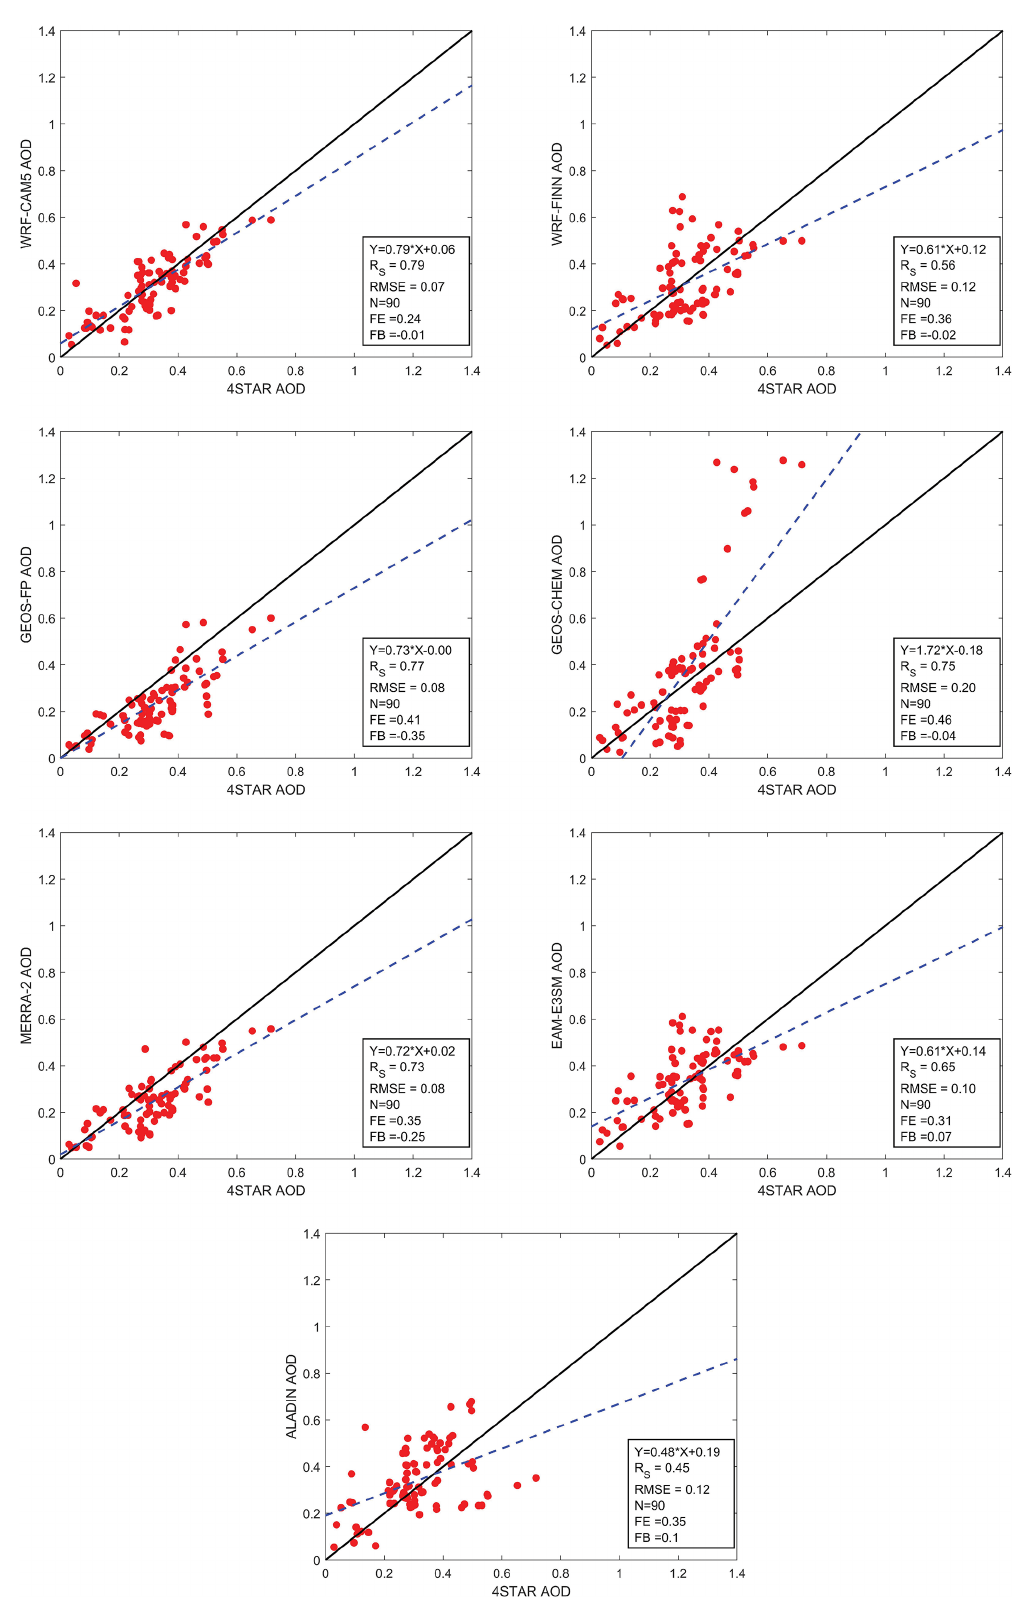
Figure 11. Scatterplots comparing modeled AOD (at 550nm) and 4STAR AOD during September 2016 of the ORACLES field experiment.